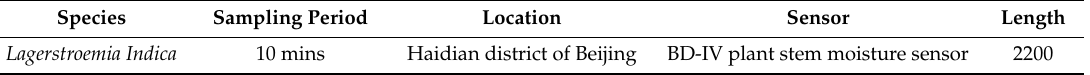
Table 3. Data source